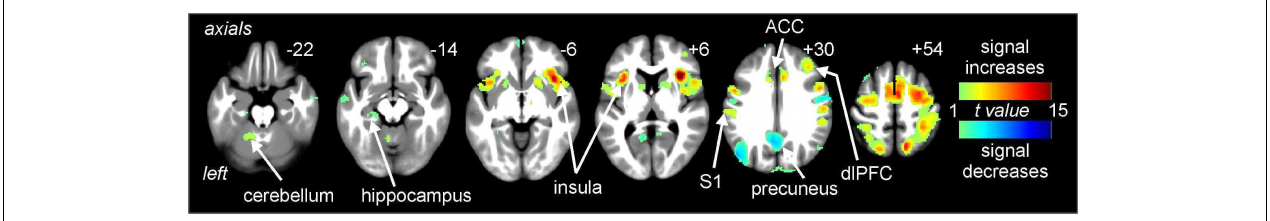
FIGURE 3 | Signal intensity changes during painful thermal stimuli. Signal increases (hot color scale) occurred in a number of regions including the insula, primary somatosensory cortex (S1), anterior cingulate cortex (ACC), and dorsolateral prefrontal cortex (dlPFC). Signal decreases (cool color scale) occurred in areas such as the precuneus. Slice locations in Montreal Neurological Institute space are indicated at the top right of each image.